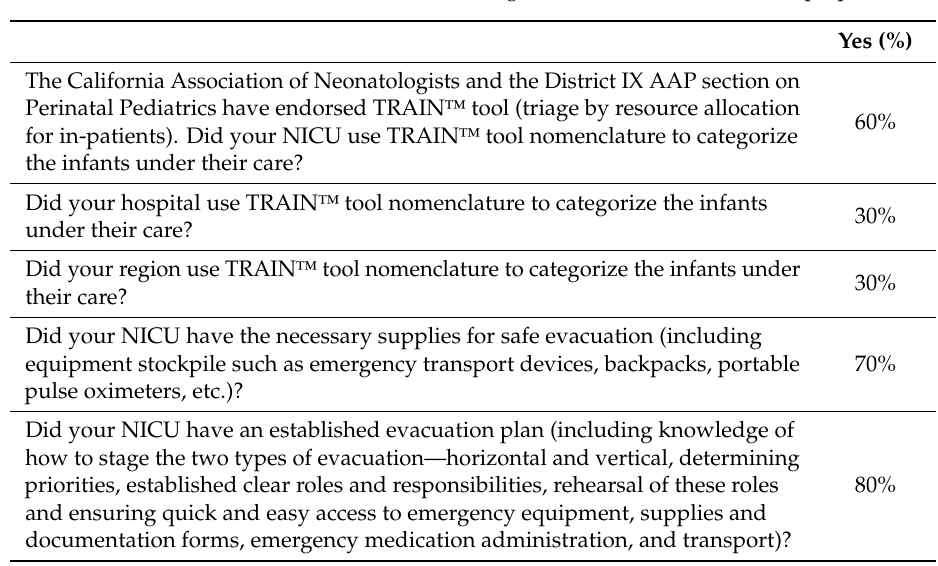
Table 2. Use of TRAIN ™ tool nomenclature to categorize infants and evacuation